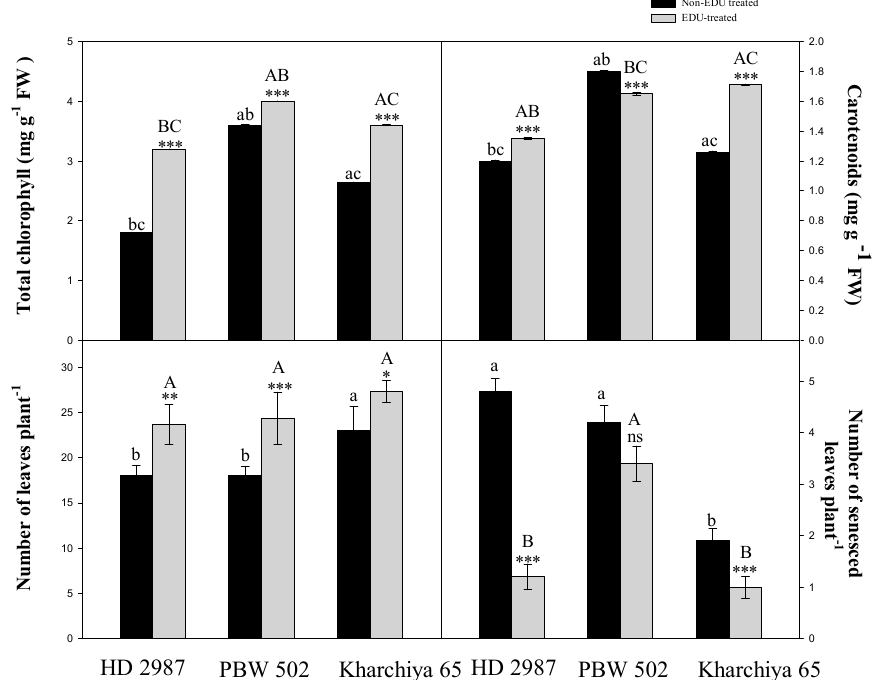
Figure 1. Effect of EDU treatment on total chlorophyll, carotenoids, number of leaves per plant and number of senesced leaves per plant in three cultivars of wheat. Values are mean ± SE; n = 9. Symbols above the bars represent significant variability between EDU- and non-EDU-treated plants. The one, two and three asterisks indicate the significance levels at *p ≤ 0.05, **p ≤ 0.01, and ***p ≤ 0.001, and ns is non-significant. Significant variations between cultivars under EDU and non-EDU treatment are respectively represented by different capital and small letters ( p < 0.05).